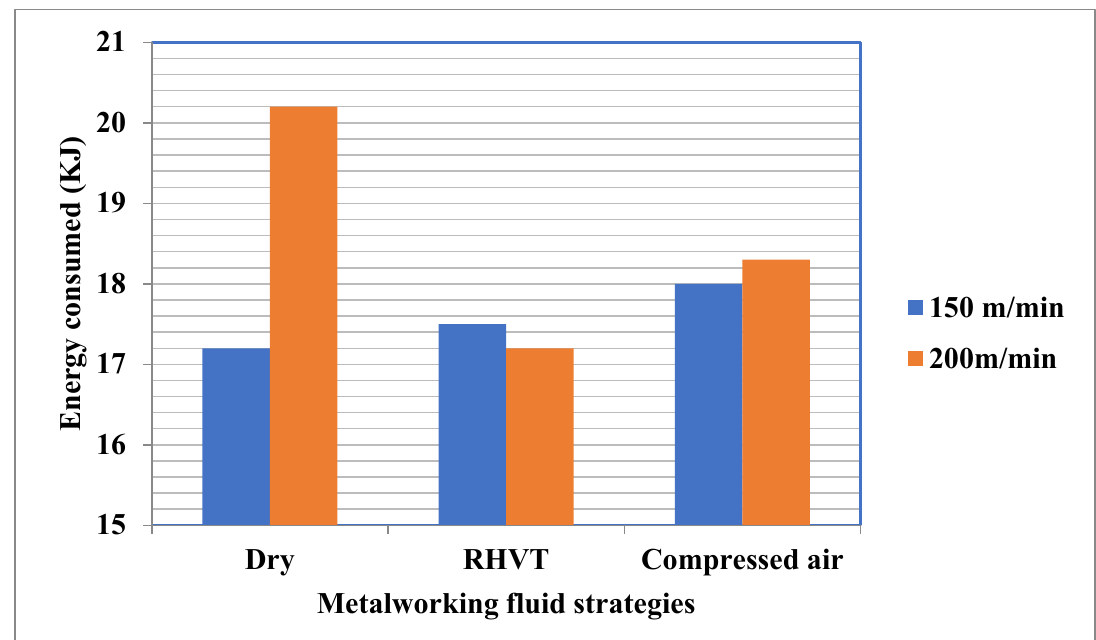
Figure 19. Energy consumed during machining for various MF strategies used at cutting speeds of 150 m/min and 200 m/min.